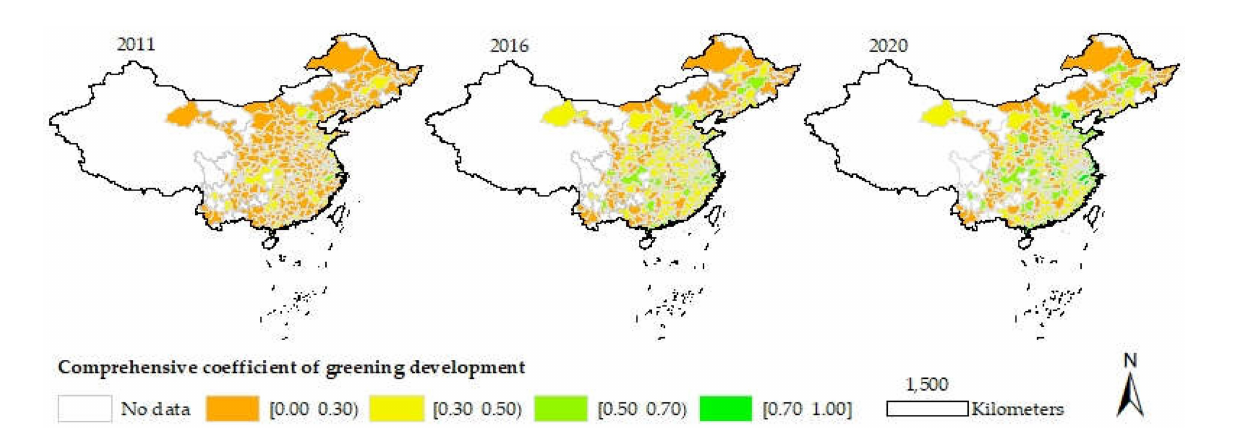
FIGURE 2 Spatio-temporal evolution of greening development in China’s cities. This map is based on the standard map of the Map Technical Review Center of the Ministry of Natural Resources [review number GS (2020) No. 4618], and the base map has not been modified.